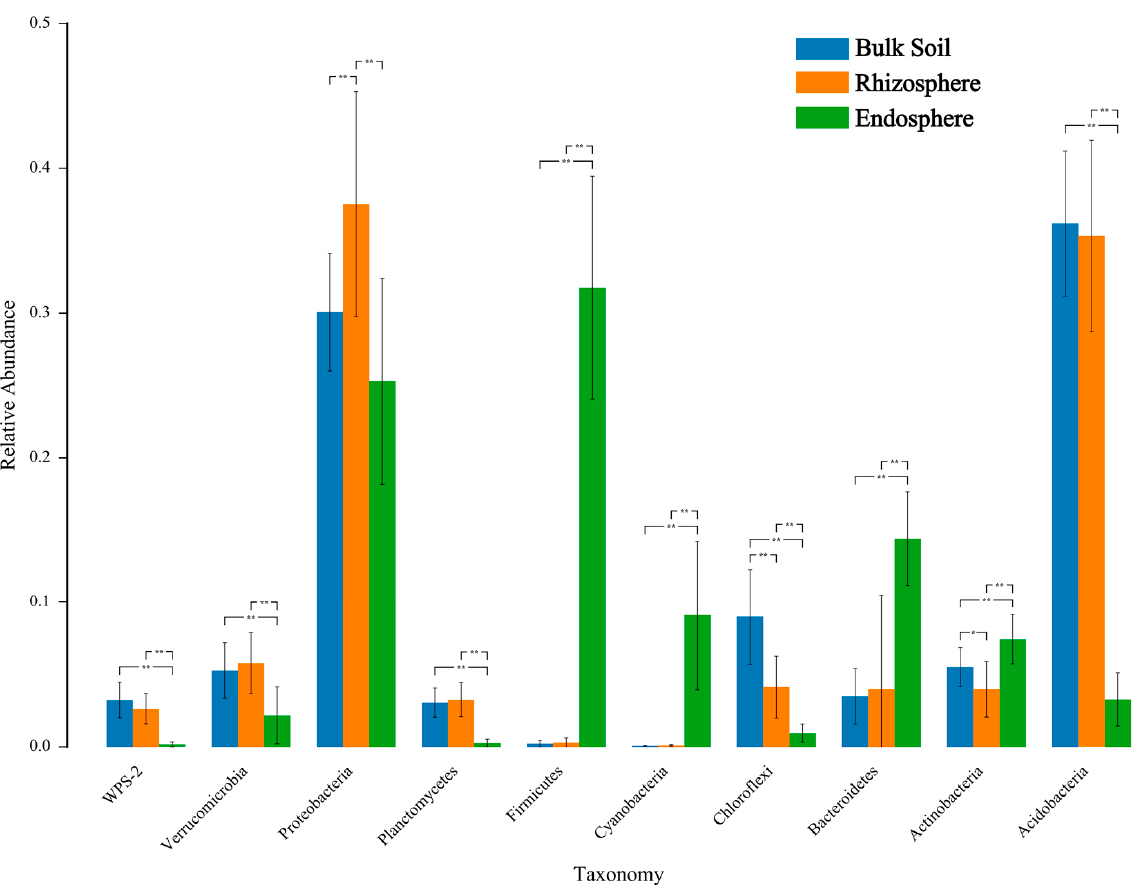
Figure 4. The X -axis represents species (the top 10 species with the lowest p values are shown); Y -axis represents the relative richness of species; columns with different colors represent samples; and * on the columns indicates that the difference is significant ( p < 0.05), ** means the difference is very significant ( p < 0.01).